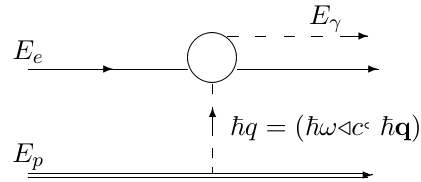
FIG. 3. Scattering of equivalent photons, forming the disk (cid:7) (cid:2) c=! , on the electron beam with radius (cid:5) ? with radius % m p